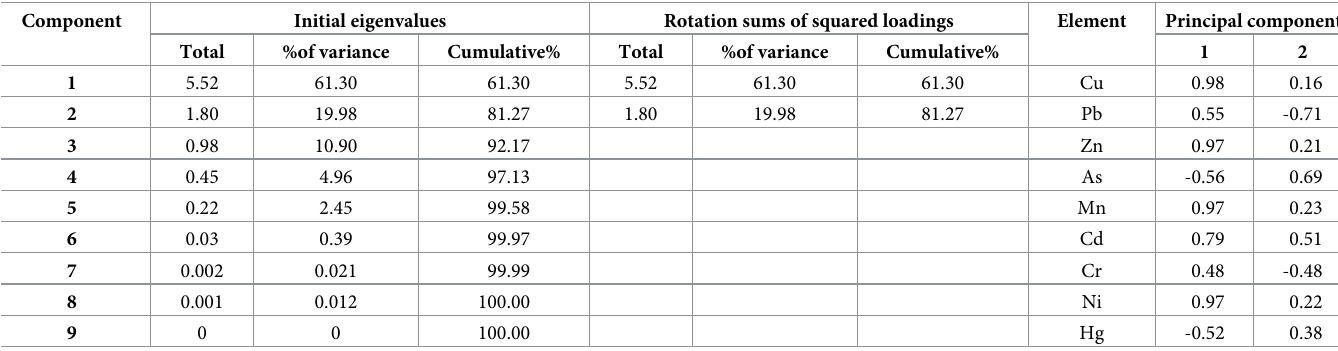
Table 10. PCA results of heavy metals in the Rongna